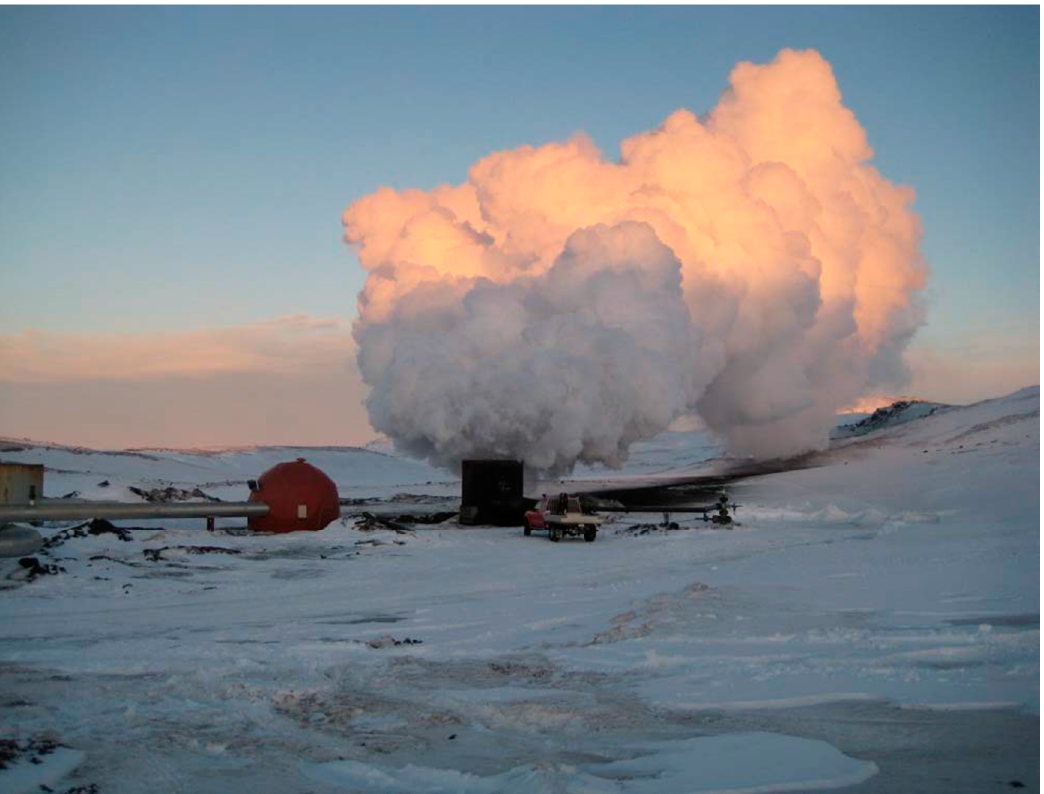
Figure 2. Flow test of Well KJ-36, Krafla Caldera, Iceland on 12 December 2007. Just two super-hot wells such as this near-magma borehole and IDDP-1, which penetrated rhyolite magma [14], could power Landsvirkjun’s 60 MWe power plant at Krafla, if the engineering challenges can be overcome. The well slants under Viti Crater (cover photo) and reaches a vertical depth of about 2500 m approximately 500 m north of the crater. Photo credit: Ásgrímur Gudmundsson.